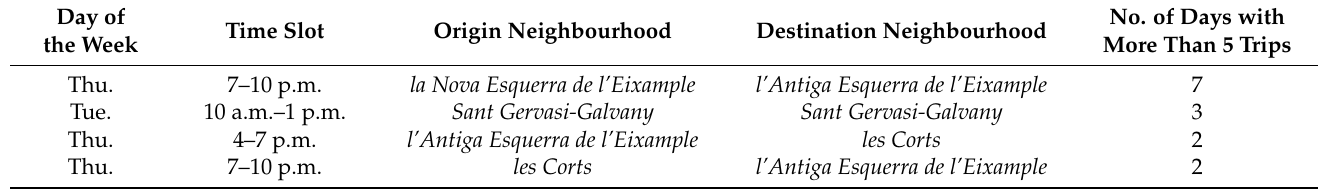
Table 5. Most frequent trips between neighbourhoods per day of the week and time slots, ordered by the number of days with more than λ = 5 trips performed in the same time